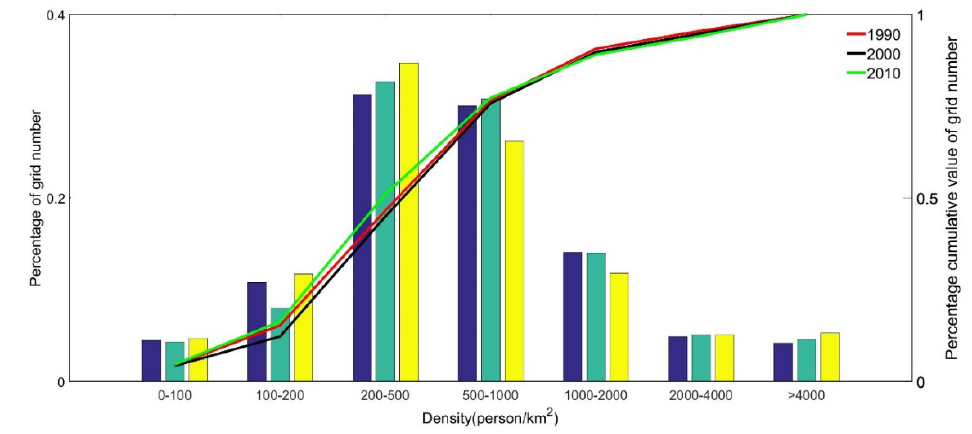
Figure 5. The area percentage of the grid number of population in 1990–2010. The histogram represents the area percentage of the grid number; the straight line represents the area percentage cumulative value of the grid number.